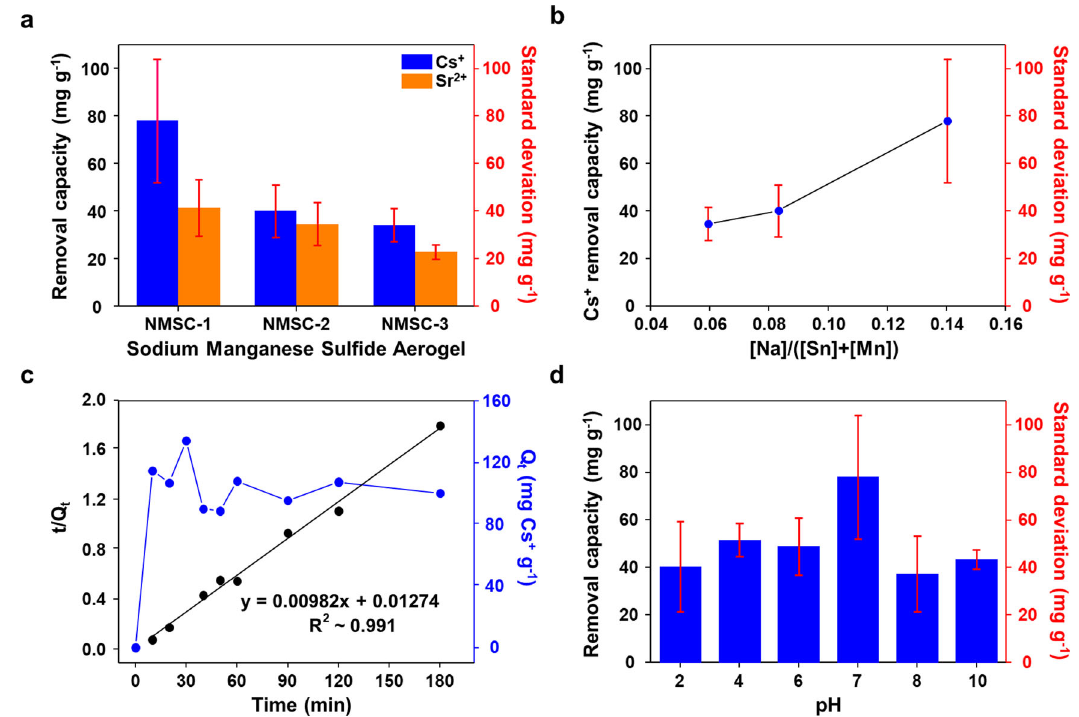
Fig.5|RadionuclideremediationpropertiesincludingerroranalysisofNMSCs. a Radionuclide (Cs + , Sr 2+ )-removal capacities of NMSCs in an aqueous solution at pH=7. b CesiumadsorptioncapacitiesoftheNMSCsatdifferentmanganeseratios, revealingthesorption-behaviordependenceontheNacontentoverthetotalmetal content in the structure. c Raw adsorption kinetic (Q t vs. time) of NMSC-1 for Cs + -